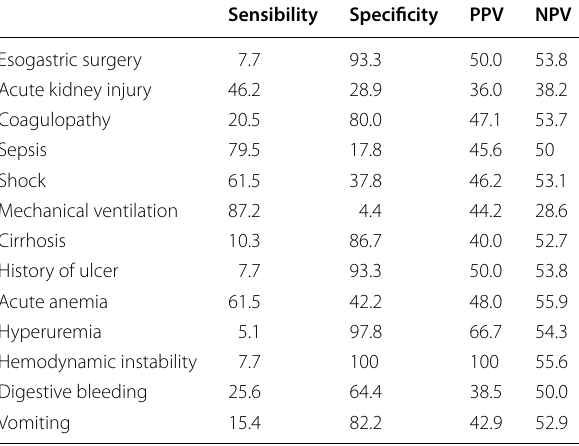
Table 4 Diagnostic and predictive values of upper gastrointestinal endoscopy in critically ill